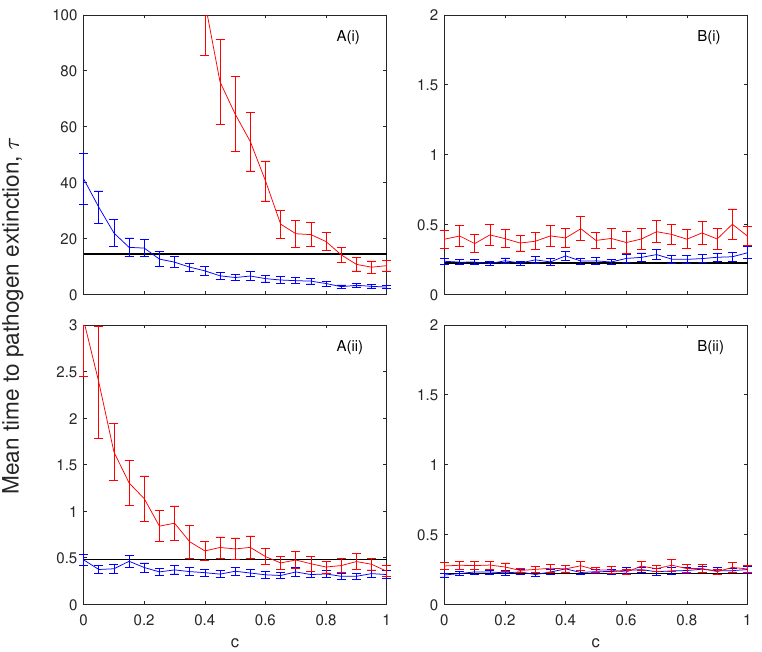
Figure 5. The mean time to pathogen extinction (with 95% confidence intervals) plotted against the proportion of disease-induced mortality incurred by chronically infected individuals compared to infected individuals. The results are shown for models with no immunity ( A ), with SIS (black), SICS and (cid:101) = 0 (blue) and SICS and (cid:101) = 0.5 (red) and for models with immunity ( B ), with SIR (black), SICR and (cid:101) = 0 (blue) and SICR and (cid:101) = 0.5 (red). In ( i ) α = 40 and ( ii ) α = 80. When not changed in the figure baseline parameter values were used (see Table 2). Note, at low levels of disease-induced mortality, α = 10, the mean time to pathogen extinction for the models without immunity exceeds our simulation time scale and so results are not